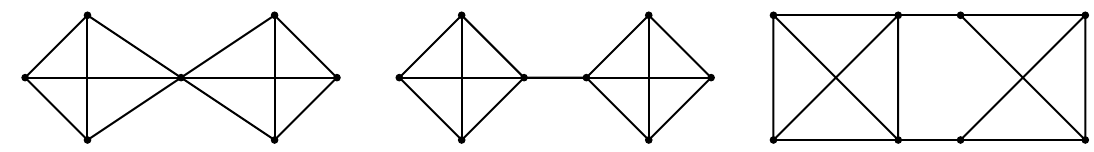
Figure 5 . The diagrams on the left and center are rejected since they would produce p-integrals with tadpoles after the cutting procedure. The condition for removal is the existence of a zero- momentum edge (manifest in the center diagram but revealed on the left only after blow-up of the higher-valence vertex). Meanwhile the rightmost diagram is rejected because it produces integrals with a double